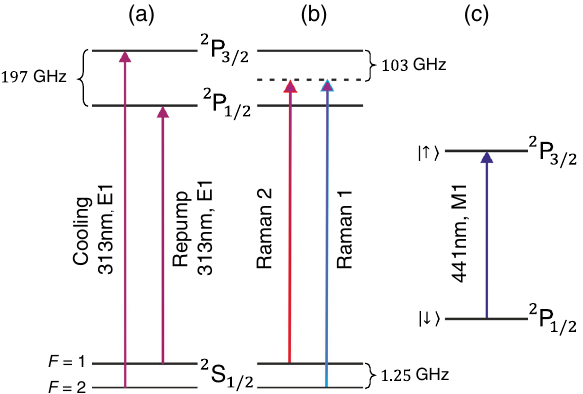
FIG. 6. Partial term schemes of 9 Be þ and 40 Ar 13 þ (energies not to scale), showing the transitions used for manipulation of the two-ion crystal. (a) Doppler cooling and repumping using the Be þ ion, (b) driving stimulated Raman transitions on the Be þ ion, and (c) driving sideband transitions using the Ar 13 þ ion. Hyper- fine sublevels of the 2 P 1 = 2 and 2 P 3 = 2 states of 9 Be þ are omitted for